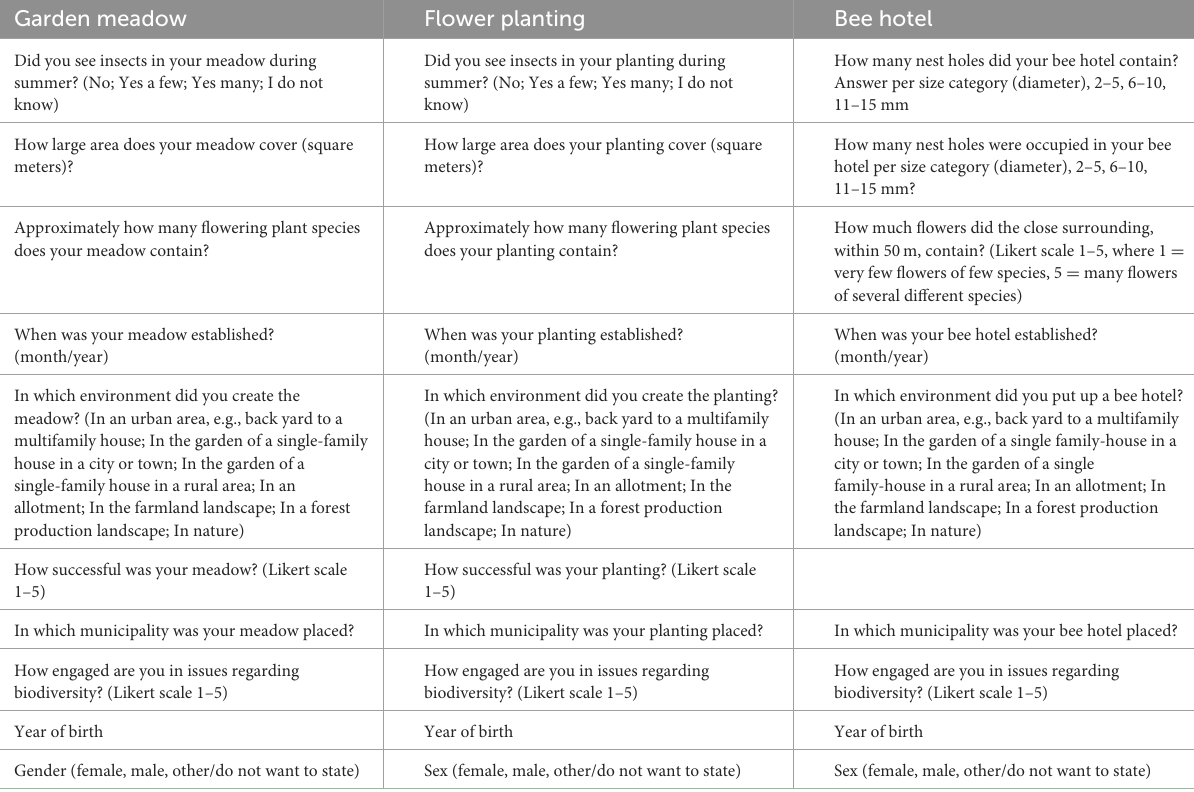
TABLE 1 The questions used to evaluate the success of interventions to benefit pollinators, with answer alternatives stated in parenthesis. Garden meadow Flower